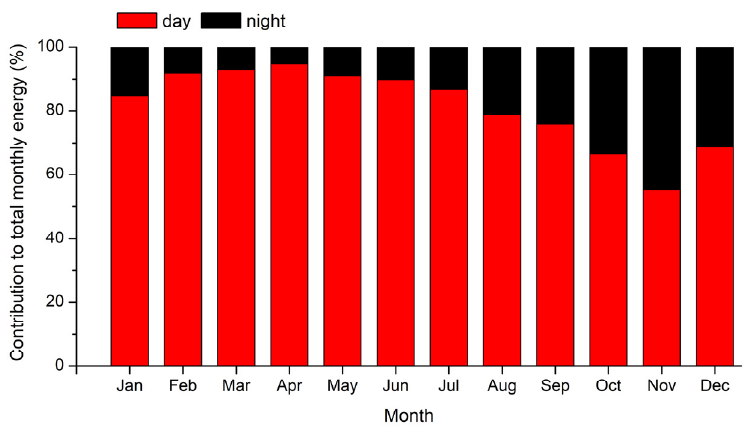
Figure 12. STEG monthly electrical energy estimated from model (year 2016). Data available in the Supplementary Materials.